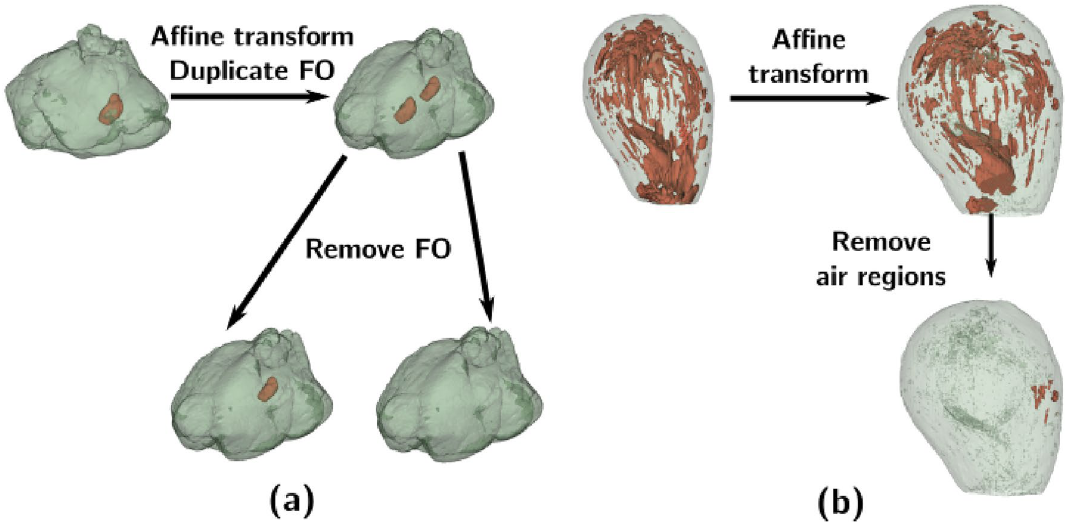
Figure 4. Artificial sample generation based on one real-world object: ( a ) for modelling clay; ( b ) for